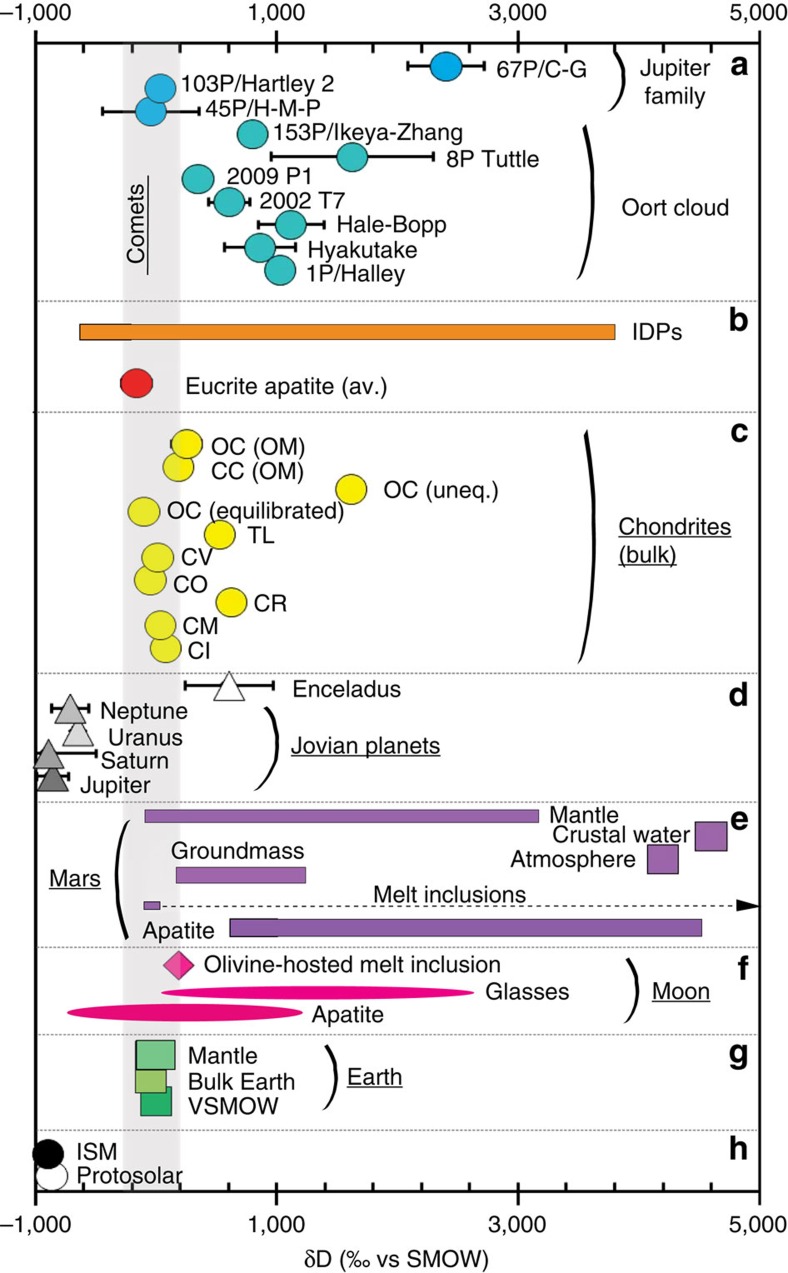
Hydrogen isotope signatures for different objects in the Solar System.The grey bar indicates the range of δD values predicted for the lunar interior based on the previous studies of water and its H-isotopic composition in lunar samples23678. (a) The H-isotopic compositions of comets, where the data for comets 1P/Halley60, Hyakutake61, Hale-Bopp62, C/2002 T7 (ref. 63), C/2009 P1 (ref. 64), 8P/Tuttle65, and 153P/Ikeya-Zhang66, 45P/Honda-Mrkos-Pajdusakova57, 103P/Hartley 2 (ref. 56) and 67P/Churyumov-Gerasimenko58. (b) The average H-isotopic composition of apatite grains from eucrites47, and the range in values for interplanetary dust particles (IDPs)6768. (c) The bulk H-isotope data for bulk Tagish Lake (TL) and other carbonaceous and ordinary chondrites (CC and OC, respectively)1155, carbonaceous and ordinary chondrite hydroxyl and organic matter54. (d) Hydrogen isotope data for Enceladus69 and the jovian planets707172. (e) The H-isotopic compositions of martian apatite737475, martian melt inclusions4674, martian meteorite groundmass46, martian atmosphere76 and martian crust and mantle46737475. (f) Data for lunar apatite5678334177, lunar picritic glasses23 and lunar olivine-hosted melt-inclusions in picritic glass beads2. (g) The range in H-isotopic compositions of H2O on Earth121378. (h) The H-isotopic composition of Proto-solar and interstellar medium42. For carbonaceous chondrites, CI-, CM-, CV-, CO- and CR- refer to the different groups, named according to one prominent meteorite of the group, respectively Ivuna, Mighei, Vigorano, Ornans and Renazzo. OC stands for ordinary chondrites. Error bars indicate measured analytical uncertainties, please see original references for more information (Encleadus, Jovian planets, and comets error bars, 1 s.d., and Eucrite data, 2 s.d.).